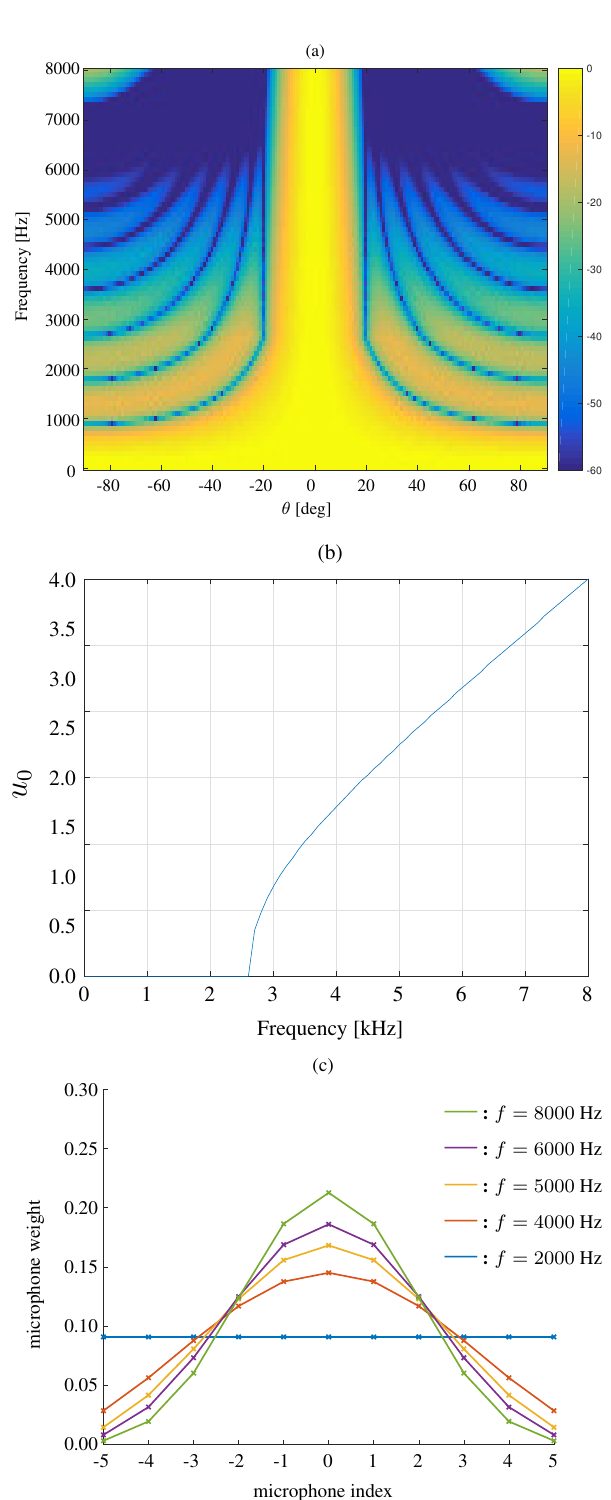
Figure 8. Constant beamwidth beamforming using the DPSS window-based method: ( a ) constant beamwidth beampattern, ( b ) the parameter u 0 , ( c ) the weights of microphones for different frequency bins. The beamwidth is fixed to 40 ◦ , M = 11, δ = 3.5